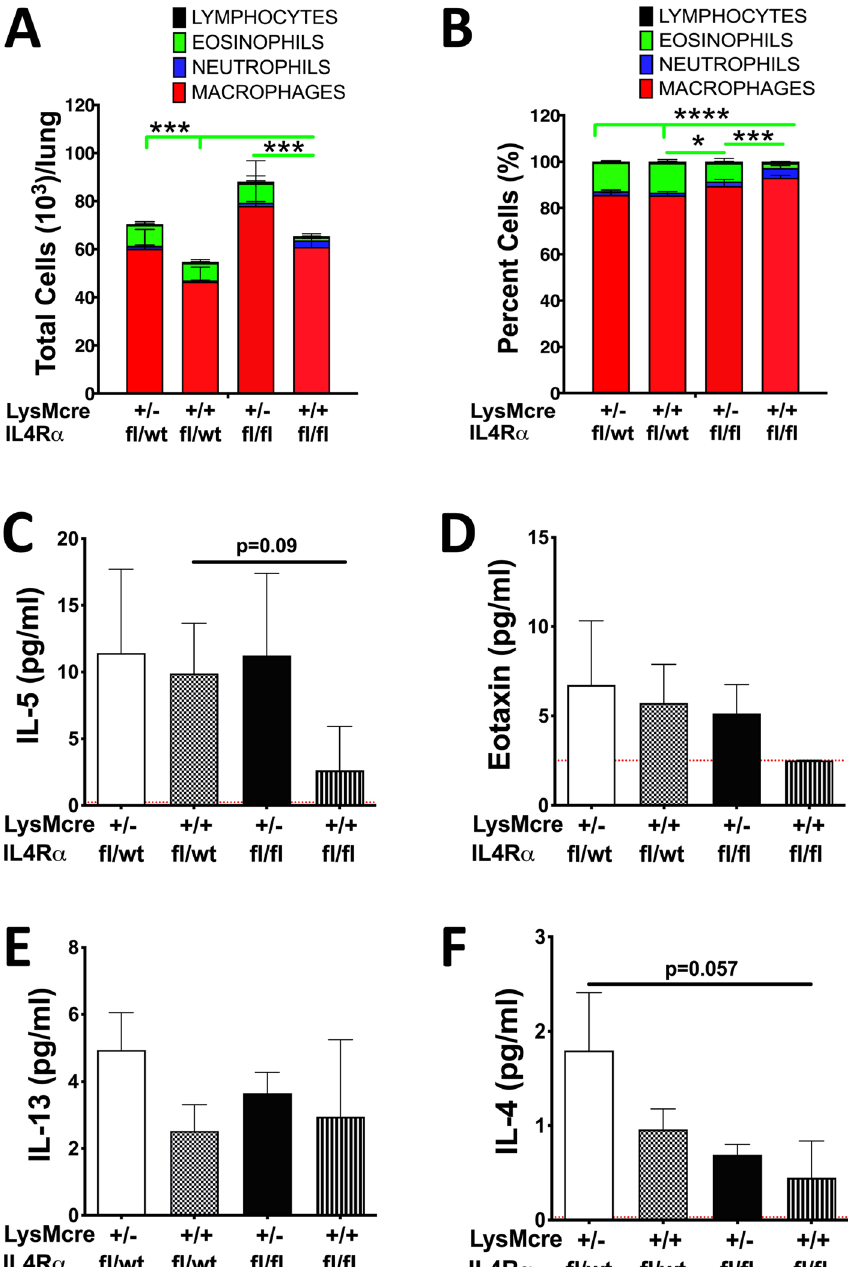
Figure 4. Eosinophilic recruitment into the lung airspaces is compromised in myeloid-specific IL4Rα-deficient mice. Cell counts in BALF from 10-day-old LysMcre +/− /IL4Rα fl/wt , LysMcre +/+ /IL4Rα fl/wt , LysMcre +/− /IL4Rα fl/fl , and LysMcre +/+ /IL4Rα fl/fl neonates. Differential cell counts (A) and relative percentages of constituent cell types ( B ) are shown as stacked bar graph [macrophages (red), neutrophils (blue), eosinophils (green), and lymphocytes (black)]. Cytokine levels (pg/ml) of IL-5 (C), Eotaxin ( D ) , IL-13 ( E ) , and IL-4 ( F ) in cell-free BALF from 10-day-old LysMcre +/- /IL4Rα fl/wt , LysMcre +/+ /IL4Rα fl/wt , LysMcre +/− /IL4Rα fl/fl , and LysMcre +/+ /IL4Rα fl/fl neonates. Error bars represent SEM. * p < 0.05, *** p < 0.001, **** p < 0.0001, using ANOVA followed by Tukey’s multiple comparison post hoc test. n = 4 per group. The lower limit of detection (indicated by red dotted lines) for IL-4, IL-13, IL-5, and Eotaxin were 0.03 pg/ml, 0.08 pg/ml, 0.25 pg/ml, and 2.51 pg/ml, respectively. The results represent cumulative data from mice generated in five different